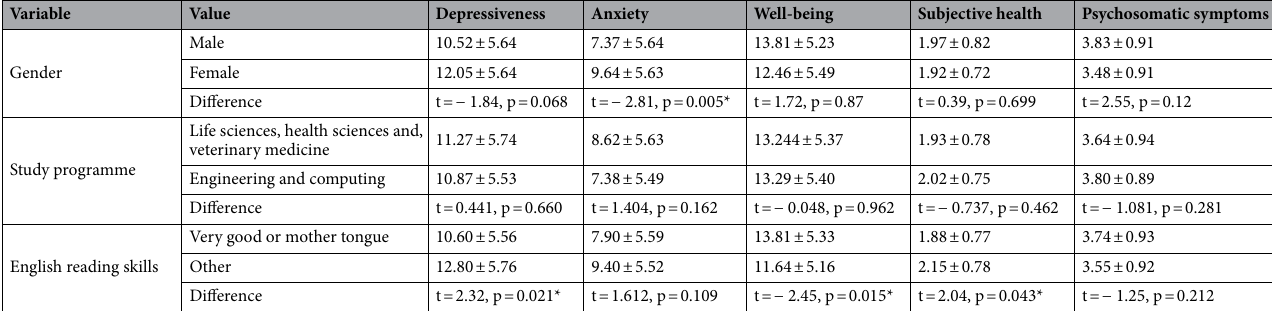
Table 3. Mental health indicators by gender and studying-related factors. *p < 0.05.